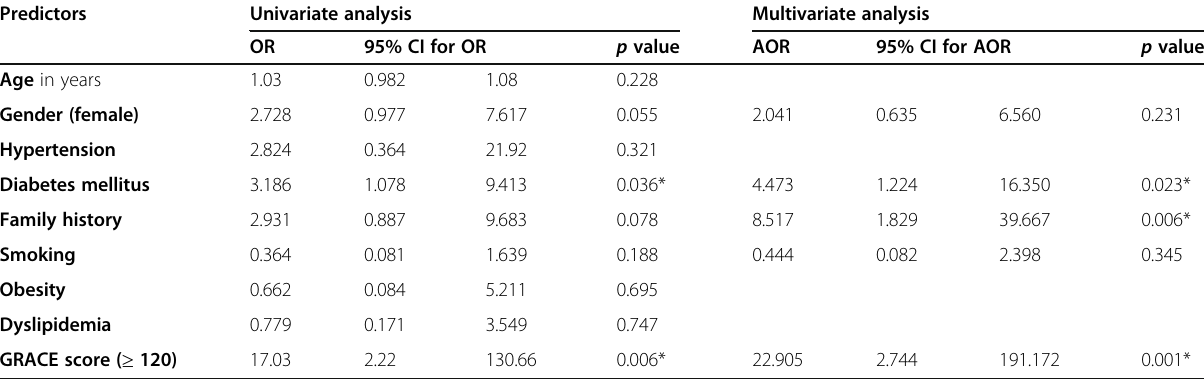
Table 2 Univariate analysis and multivariate analysis for in-hospital mortality Predictors